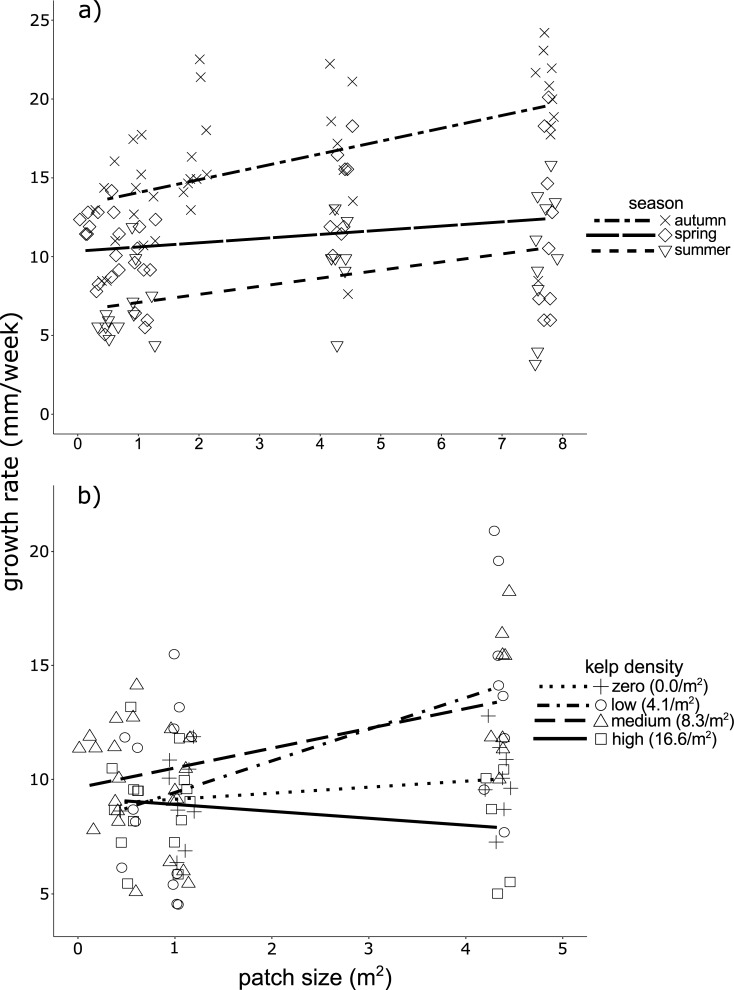
Growth rates of macroscopic juvenile Ecklonia radiata sporophytes.Measurements taken 90 days after transplanting to (a) patches at normal kelp density (8.3 kelp/m2) across three seasons, and (b) patches of varying kelp density during spring. Note the different y-axis scale.